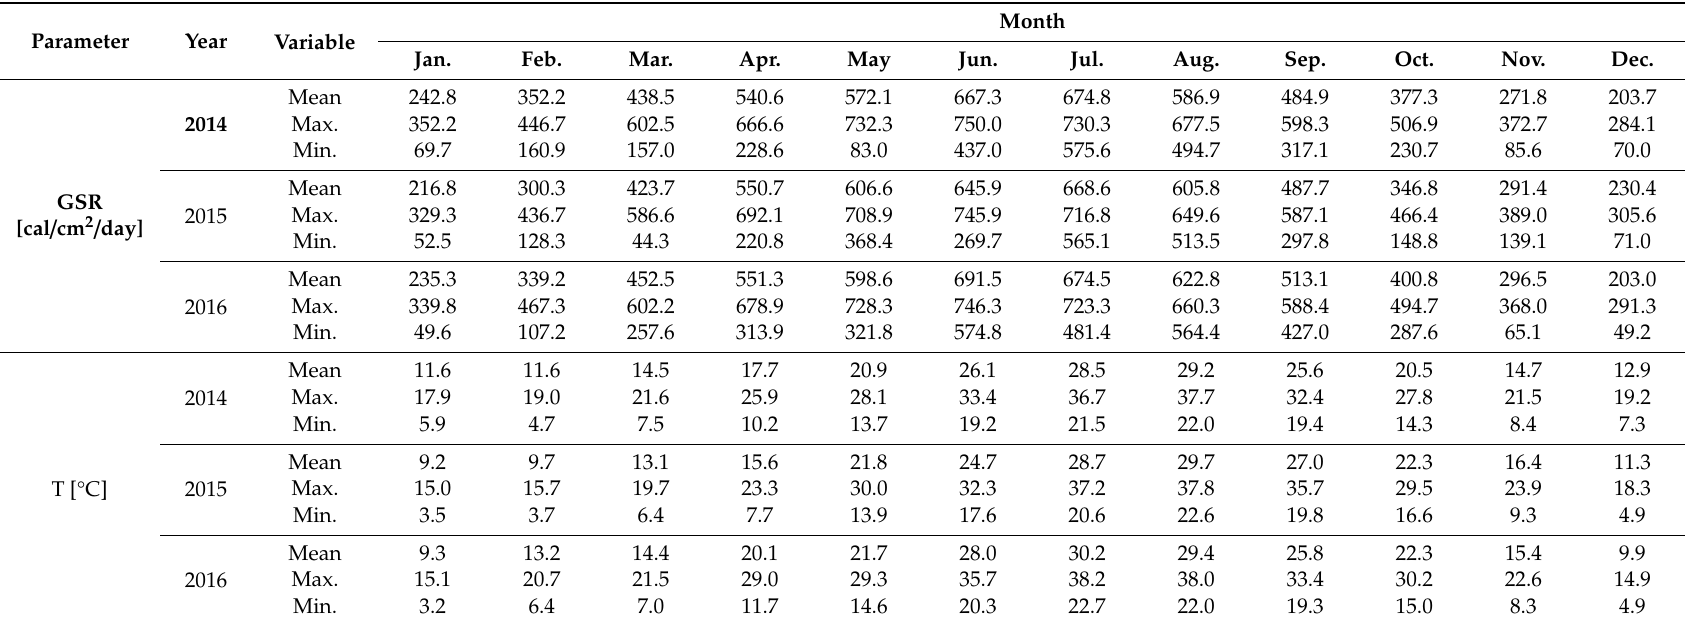
Table 7. Mean, maximum, and minimum monthly meteorological